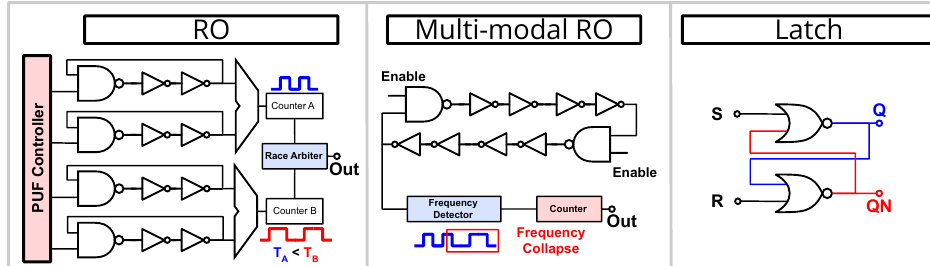
Figure 5. The PUF architectures based on RO, multi-modal RO, and latches.